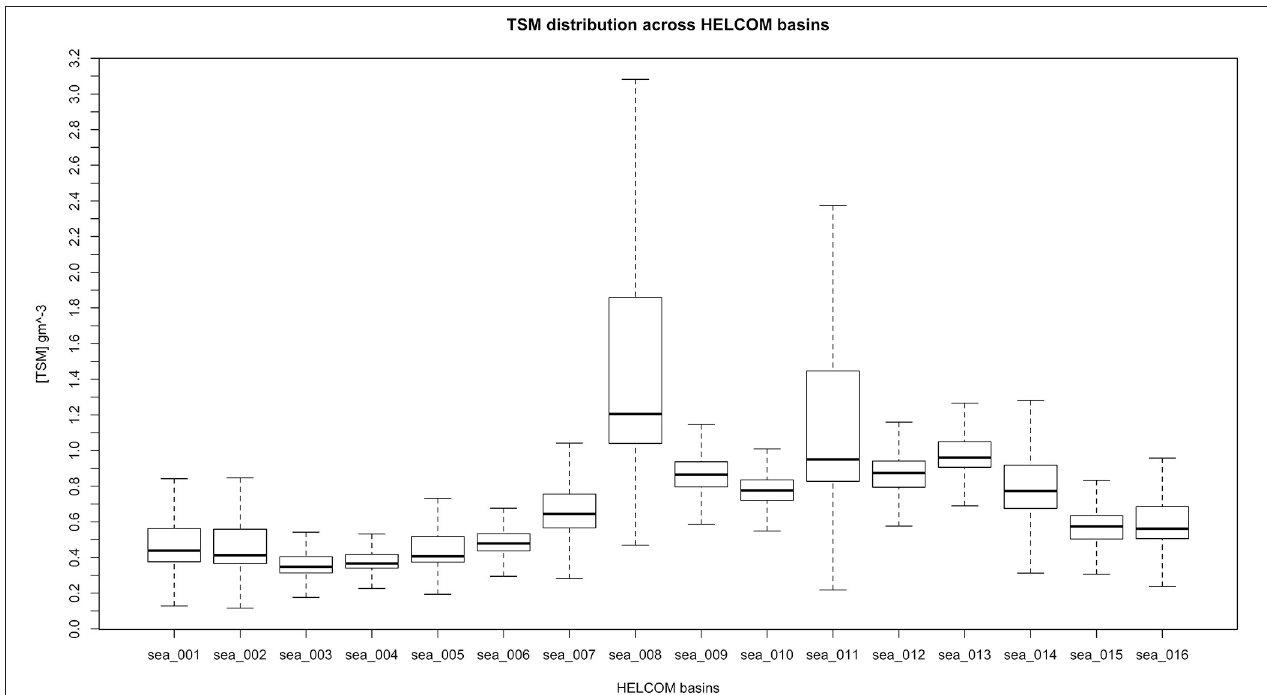
FIGURE 4 | Box-and-whisker plot comparison of TSM concentrations (box: interquartile range; horizontal line: median; whiskers: upper and lower fence) between HELCOM basins for a 3-year summer composite.